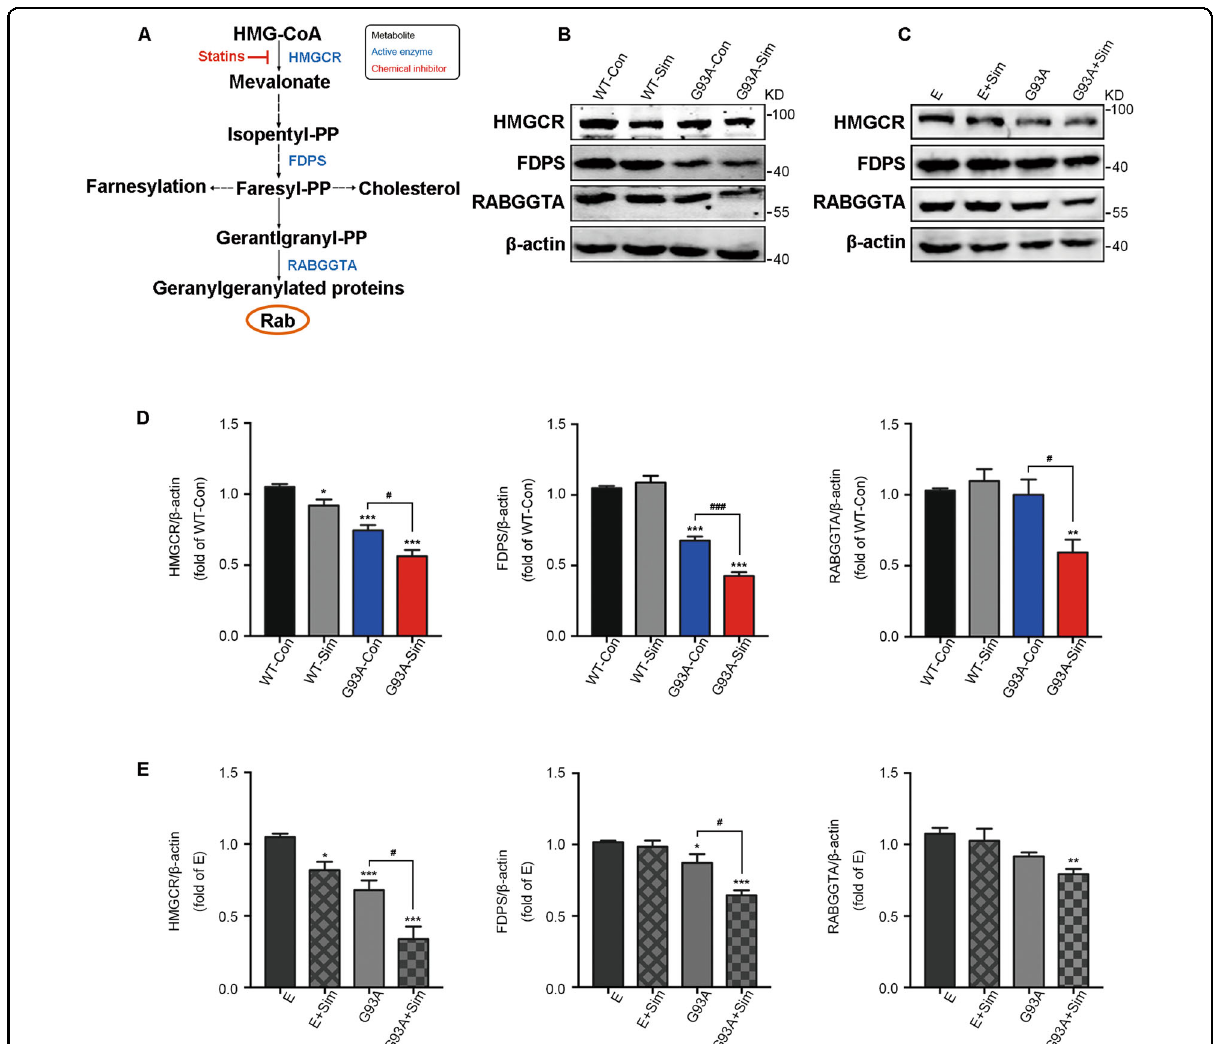
Fig. 7 Effect of simvastatin on the mevalonate pathway in SOD1 G93A mice and NSC34-hSOD1 G93A cells. A Schemetic of the mevalonate pathway. B Western blot analysis of levels of HMGCR, FDPS, and RABGGTA in the lumbar spinal cord at 120 days. C Western blot analysis of the levels of HMGCR, FDPS, and RABGGTA in each group. NSC34-E and NSC34-hSOD1 G93A cells were treated with Simvastatin (1 µM) for 24 h. D Quantitative analysis of expression of HMGCR, FDPS, and RABGGTA in WT and SOD1 G93A mice treated or untreated with simvastatin respestively. E Quantitation of HMGCR, FDPS, and RABGGTA in NSC34-E and NSC34-hSOD1 G93A cells treated or untreated with simvastatin. (Data represent the mean ± SEM, n = 5 mice or 20 cells per group; statistical signi fi cance was assessed by one-way ANOVA or an unpaired t -test, * P ≤ 0.05, ** P ≤ 0.01, *** P ≤ 0.001, # P ≤ 0.05, ## P ≤ 0.01, ### P ≤